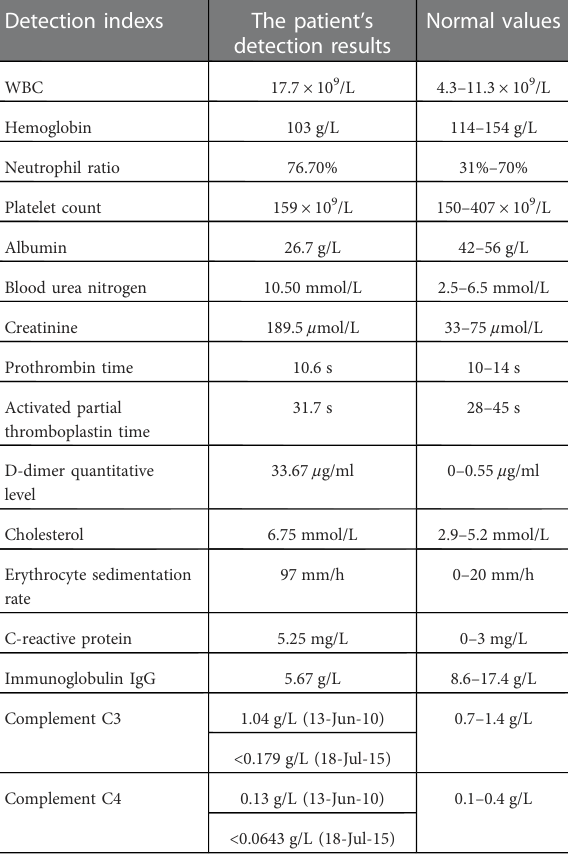
TABLE 1 The patient ’ s results and normal values of speci fi c detection indexes. Detection